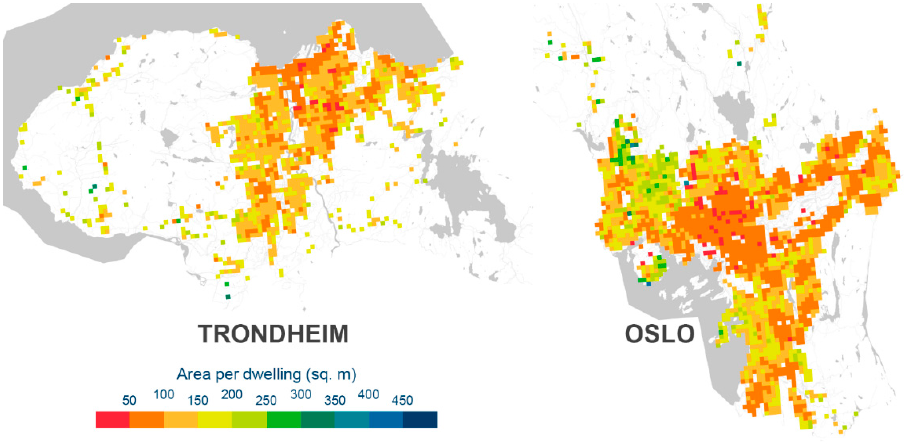
Figure 1. Mean area (GIA in m 2 ) per dwelling for each grid cell in Trondheim and Oslo. Both in Oslo and Trondheim, dwellings in the city center are, with few exceptions, smaller than 100 m 2 (in some cases also less than 50 m 2 ) on average and at the same time have low numbers of residents per dwelling (Figure 2). The maps show clear patterns of low resident counts in central areas in both cities, while other areas are more diverse. For Trondheim, the student housing areas Berg and Moholt can be distinguished with low resident counts (in most cases 1 resident per dwelling).